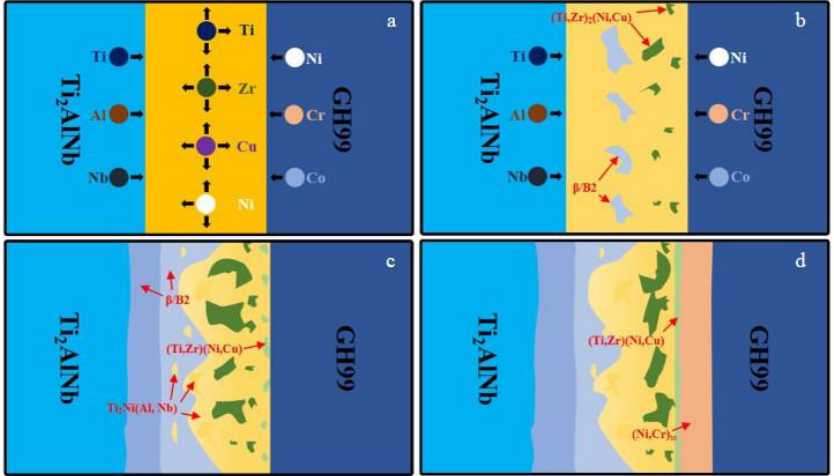
Figure 8. Schematic diagram of the microstructure evolution. ( a ) atomic migration; ( b ) nucleation of β -Ti and (Ti, Zr) 2 (Ni, Cu); ( c ) nucleation of Ti 2 Ni (Al, Nb) and (Ti, Zr)(Ni, Cu); ( d ) final solidification stage.